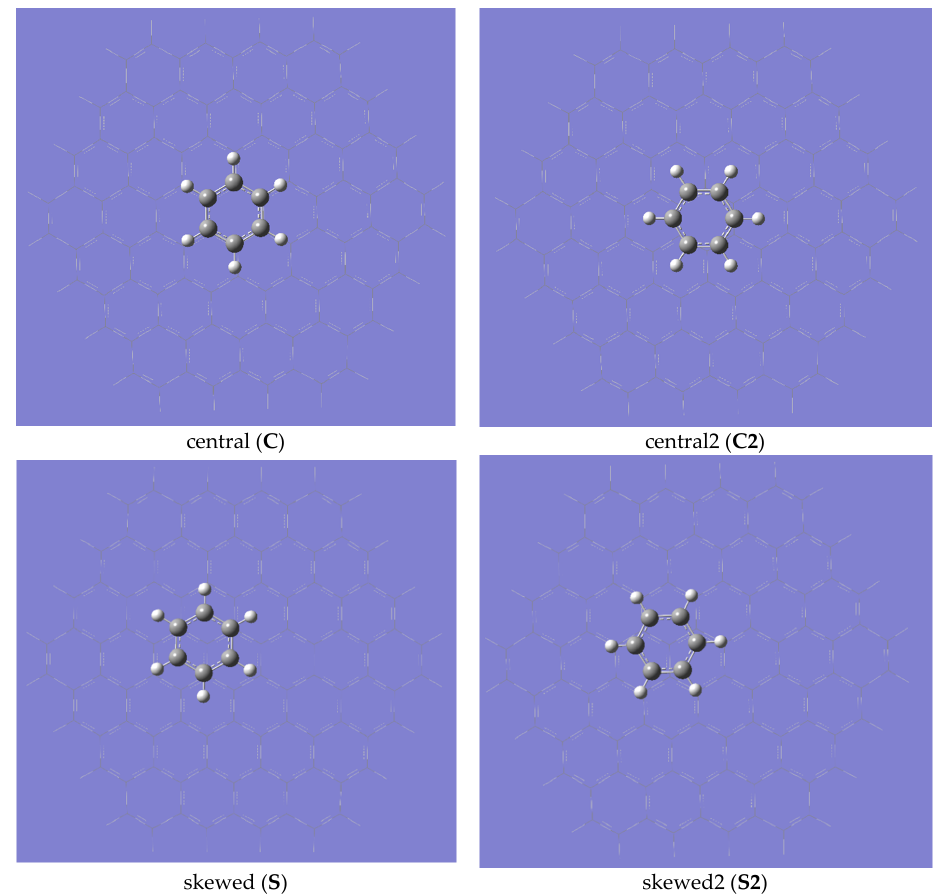
Figure 1. The positions of the benzene ring over the graphene sheet.